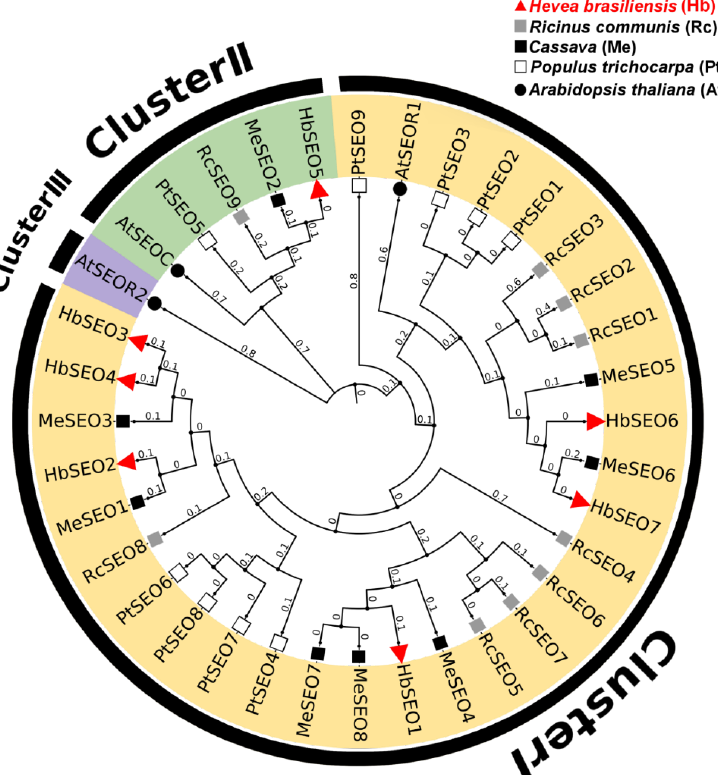
Figure 2. Phylogenetic analysis of SEOs from H. brasiliensis, A. thaiana, M. esculenta, R. communis, and P. trichcarpa . All complete protein sequences were aligned using MEGA-X software, and the phylogenetic tree was displayed using EvolView. The phylogenetic tree was constructed using the maximum likelihood method and JTT matrix-based model, with bootstrap replications of 1000. The numbers on branches indicate the evolutionary distance.